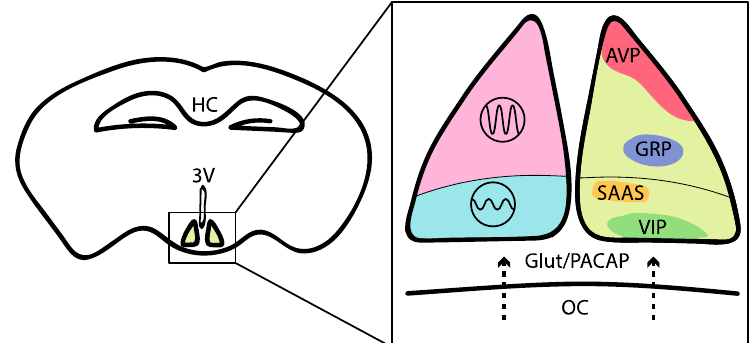
Figure 2. Anatomy of the suprachiasmatic nucleus. A schematic of a coronal slice of the mouse brain showing the location of the suprachiasmatic nucleus (SCN) in the hypothalamus above the optical chiasma (OC). The detailed portion shows the distinct anatomical sections of the SCN. The dorsal and ventral SCN are in pink and blue respectively. Subsets of SCN neurons are shown on the right: GABA + (yellow), VIP + (green), AVP + (red), SAAS + (gold) and GRP + (purple) are expressed in the dorsal SCN. DRD1a + (most SCN cells) and NMS + neurons (~40%) are not shown. HC- Hippocampus, 3V- third ventricle.